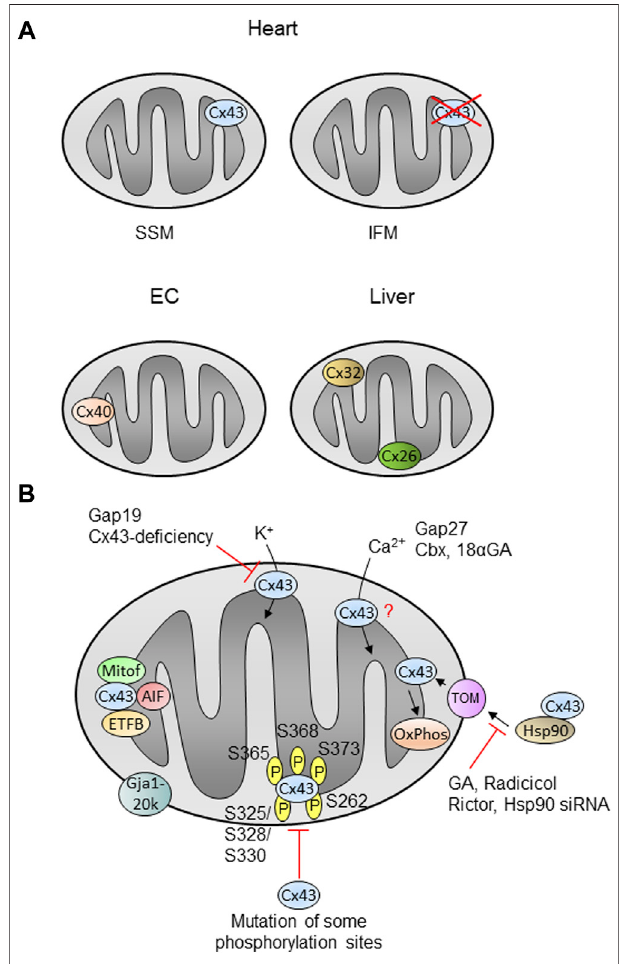
FIGURE 2 | Mitochondrial localization and function of connexins in cells or organs. (A) The localization and function of mitochondrial Cx43 is best described in the heart, where the protein is present in SSM (subsarcolemmal mitochondria), but is nearly absent in inter fi brillar mitochondria (IFM). Cx43 is also detected in mitochondria of other cells or organs (see text). Cx40 is found in mitochondria of endothelial cells (EC), whereas liver mitochondria contain Cx32 and Cx26. (B) Cx43 is imported into cardiac SSM in a pathway involving Hsp90 (heat shock protein 90) and TOM proteins (translocase of the outer membrane) and is fi nally inserted into the inner membrane. Inhibition of Hsp90 using geldanamycin (GA), radicicol or Hsp90 siRNA as well as Rictor decreases the mitochondrial Cx43 amount. The amino acids known to be phosphorylated within Cx43 are indicated by ℗ . Mutation of some phosphorylation sites decreases the mitochondrial Cx43 amount. Proteins knowntointeract withmitochondrialsuch asmito fi lin(Mitof), apoptis-inducing factor (AIF) or the beta-subunit of the electron transferprotein (ETFB) are shown. Mitochondrial Cx43 presumably forms hemichannels and the inhibition of such channels using Gap19 or by Cx43-de fi ciency decreases the potassium fl uxintotheorganelles. Calcium ion(Ca 2+ )uptakeismodi fi edinthe presence of the inhibitors Gap27, carbenoxolone (Cbx) or 18 α -glycyrrhetinic acid (18 α GA), however, the exact role of mitochondrial Cx43 in this process is unclear (?). Cx43 in fl uences oxidative phosphorylation (OxPhos). The N-terminally truncated form of Cx43, Gja1-20k, localizes at the outer mitochondrial membrane. | − : inhibition; for further details see